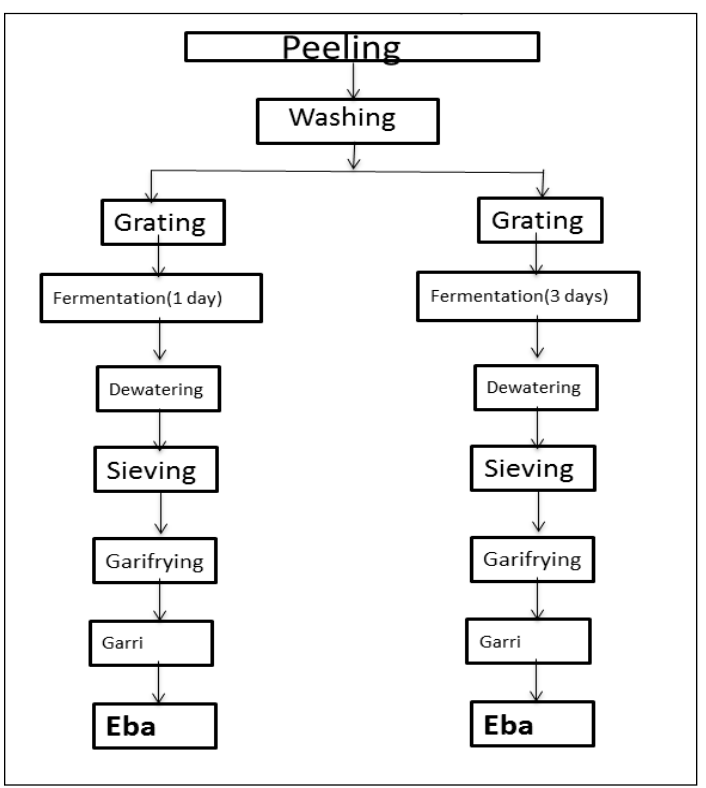
Figure 1. Schematic diagram of steps involved in the processing of fresh raw cassava roots into Garri and Eba using two fermentation periods [24–27].